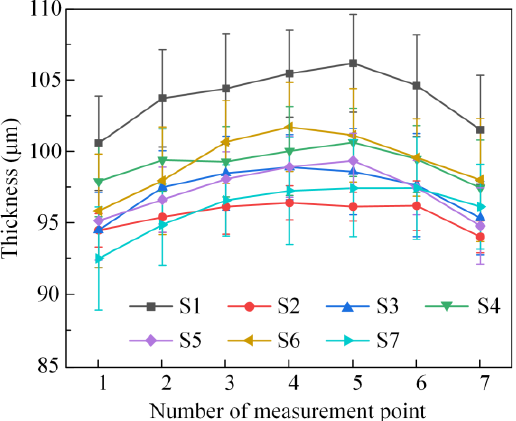
Figure 6. Measured thicknesses of the TC layers of the specimens after different numbers of thermal cycles.